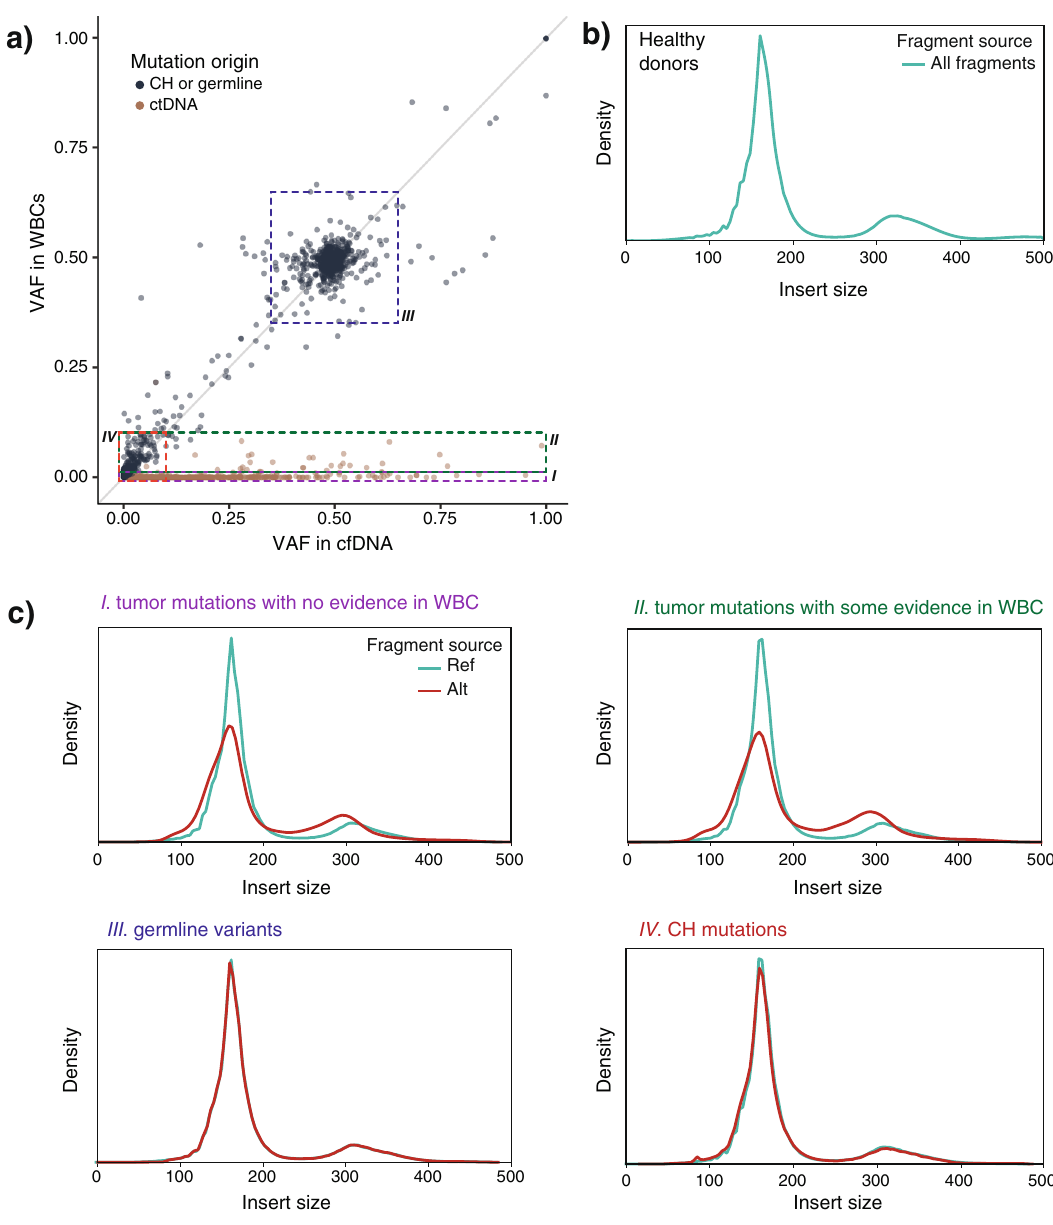
Fig. 4 Use of WBC sequencing data to classify variants found in cfDNA. a VAF distribution of all mutations called in plasma from cfDNA and WBCs. Colors indicate the origin of mutations. Boxes indicate different populations of mutations: I: Variants only present in cfDNA, II: Variants present in cfDNA at high VAF but also present in WBC at lower VAF, III: Variants present in both cfDNA and WBCs with VAFs in the presumed germline range (35 – 65%), IV: Variants present in both cfDNA and WBCs with VAFs lower than 10% in both. b Insert size distribution of sequencing reads (fragment size) in healthy donors with characteristic peaks at 161 bp and 317 bp c Fragment size distribution for reads encompassing the variants highlighted by the boxes and labels in ( a ) for both reference and alternate alleles. Clear differences are observed for reads originating from ctDNA vs normal (Fig. 4c - IV) (bootstrapped p value = 0.99), adding con fi dence to